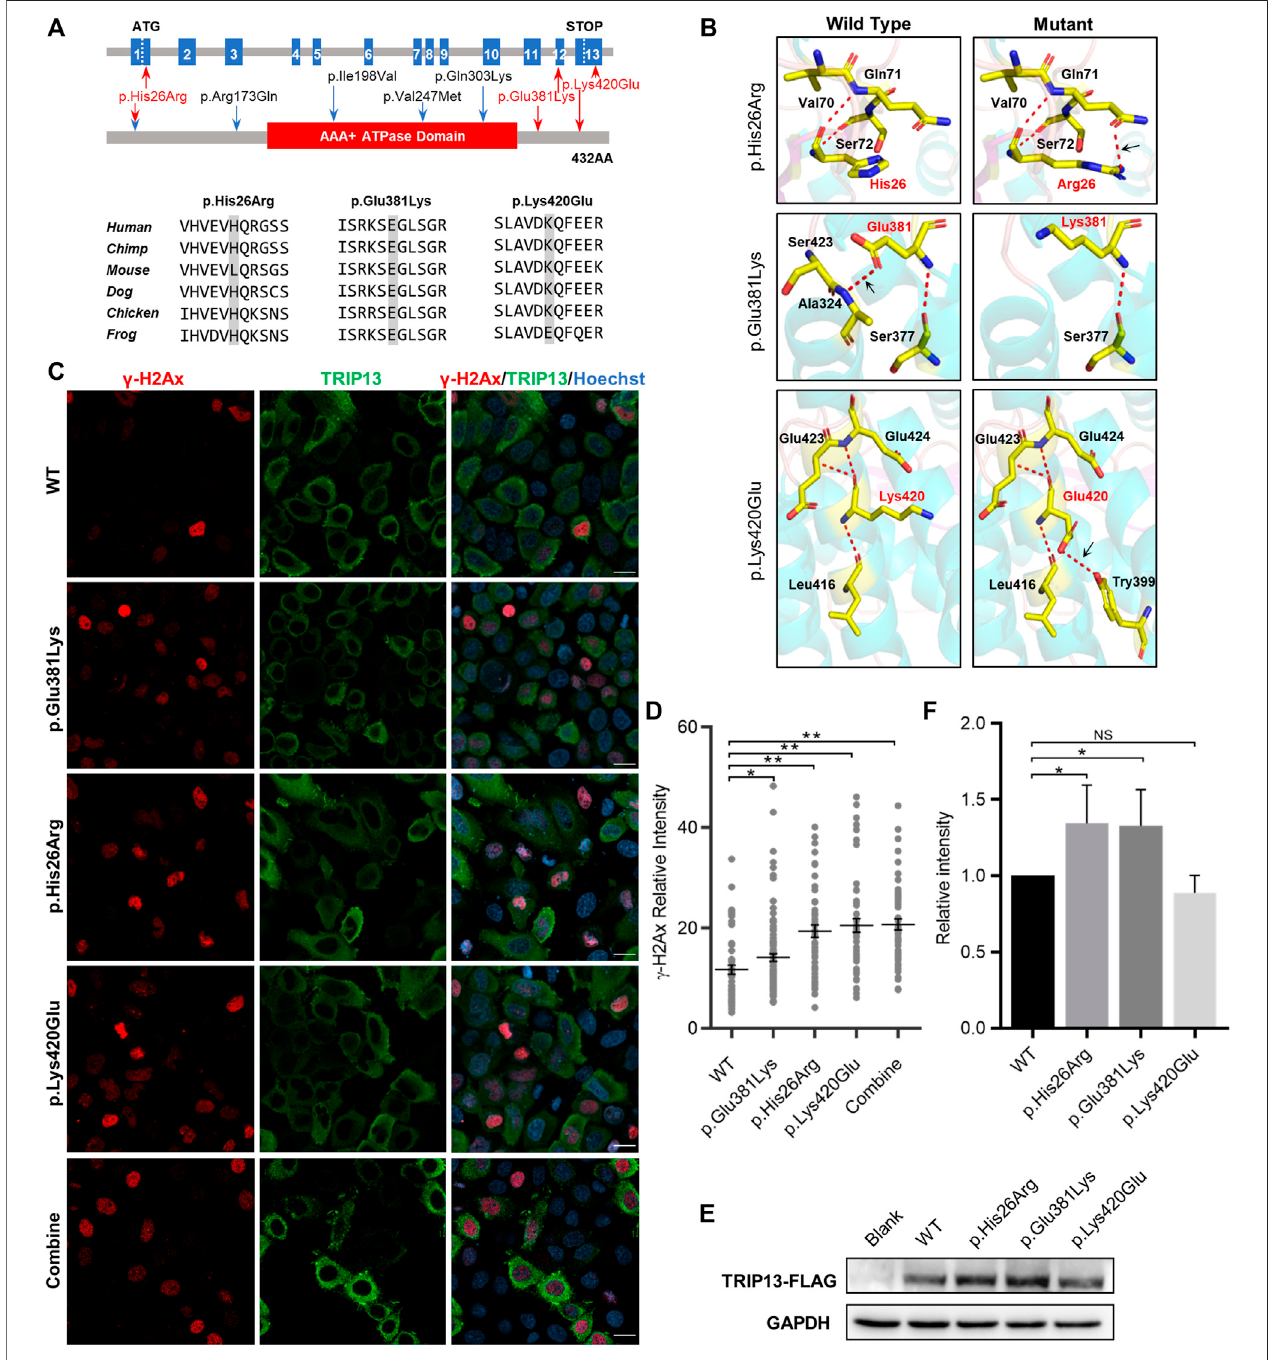
FIGURE2| Effectsof TRIP13 variantsonpredictedconformation,locationofTRIP13proteinandDNAdamagelevelinHeLacells. (A) Localizationofvariantsinthe genome(top)andinaschematicoftheTRIP13proteinstructure(middle),andconservationofmutatedaminoacidsinthevariantsinsixspecies(bottom).Theredarrows indicate novel variants identi fi ed herein; blue arrows indicate previously reported variants. (B) Protein conformation predictions of TRIP13 variants. Red dashed lines represent hydrogen bonds and black arrows indicate hydrogen bond changes. (C) Effects of TRIP13 variants on cellular localization of TRIP13 protein and DNA damage level in transfected HeLa cells. “ combine ” indicated co-transfected the p. Glu381Lys and p.Lys420Glu plasmids into the HeLa cells. Scale bar = 20 μ m. (D) Statistical analysis of γ H2Ax intensity shown in panel (C) . Data are the mean ± SD. (E) Effects of TRIP13 variants on TRIP13 protein levels in transfected HeLa cells. (F) Statistical analysis of TRIP13 protein abundance shown in panel (E) . The relative protein intensities of FLAG/GAPDH in the WT group were set as 1. Data are the mean ± SD.